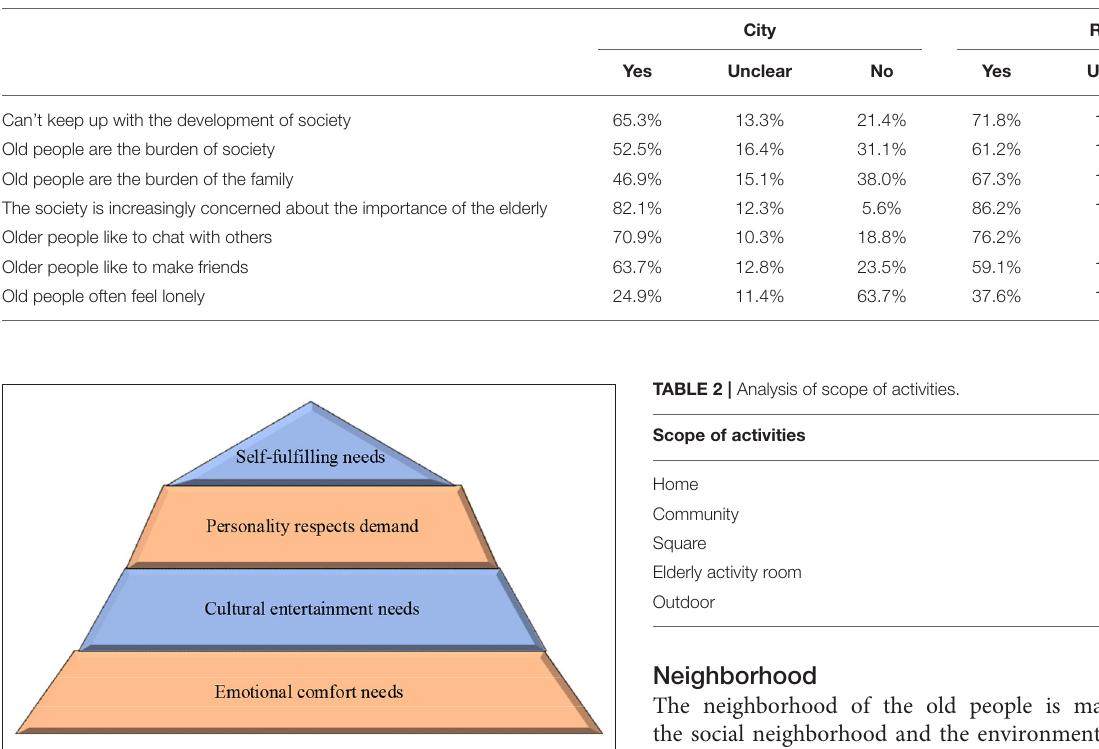
TABLE 1 | Composition of various statements of the elderly in the surveyed cities and rural areas.